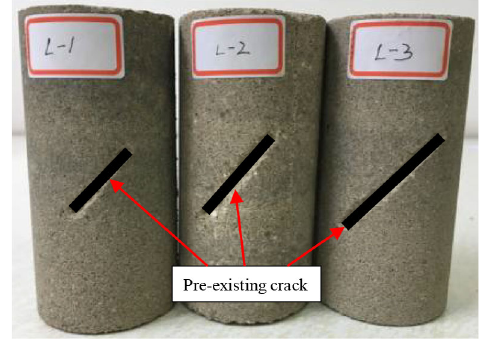
Fig. 2 Prepared specimens with different length of pre-existing